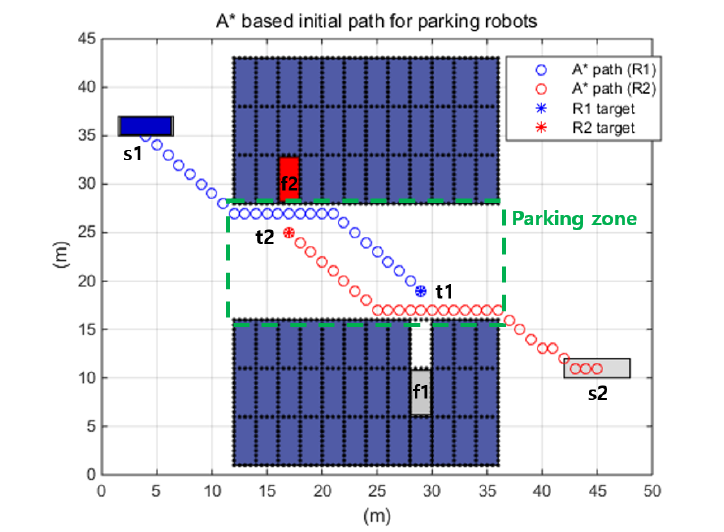
Figure 13. Autonomous parking